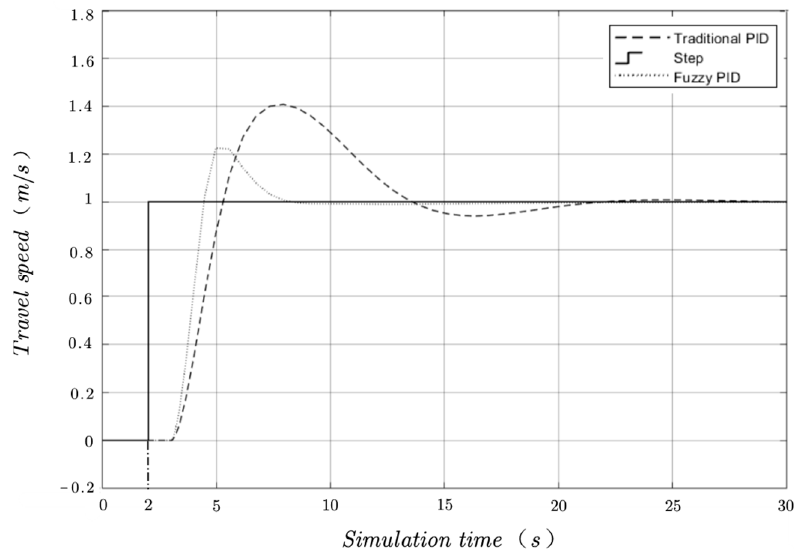
Figure 15. Simulation results of adaptive adjustment to the harvester’s traveling speed.